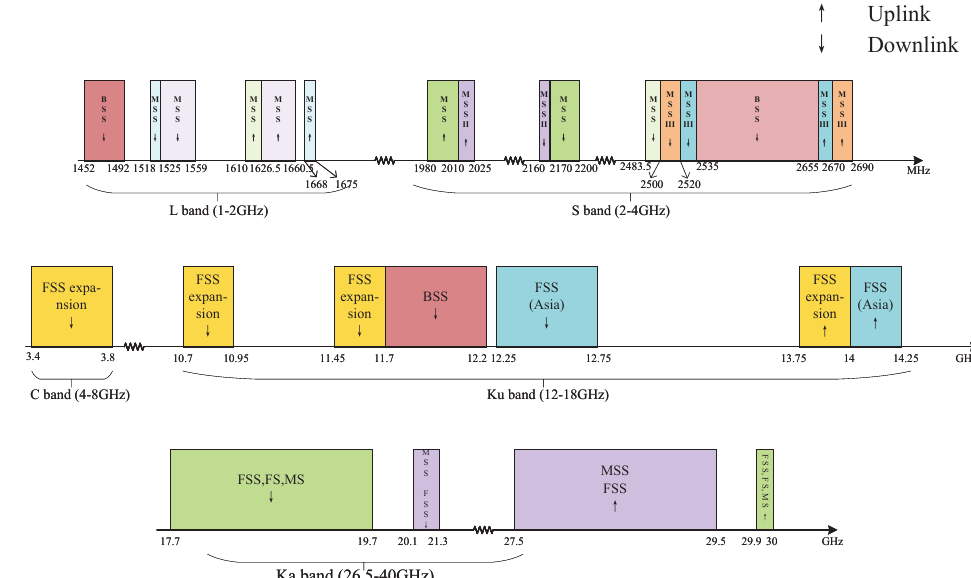
Figure 6. Current spectrum utilization rules of